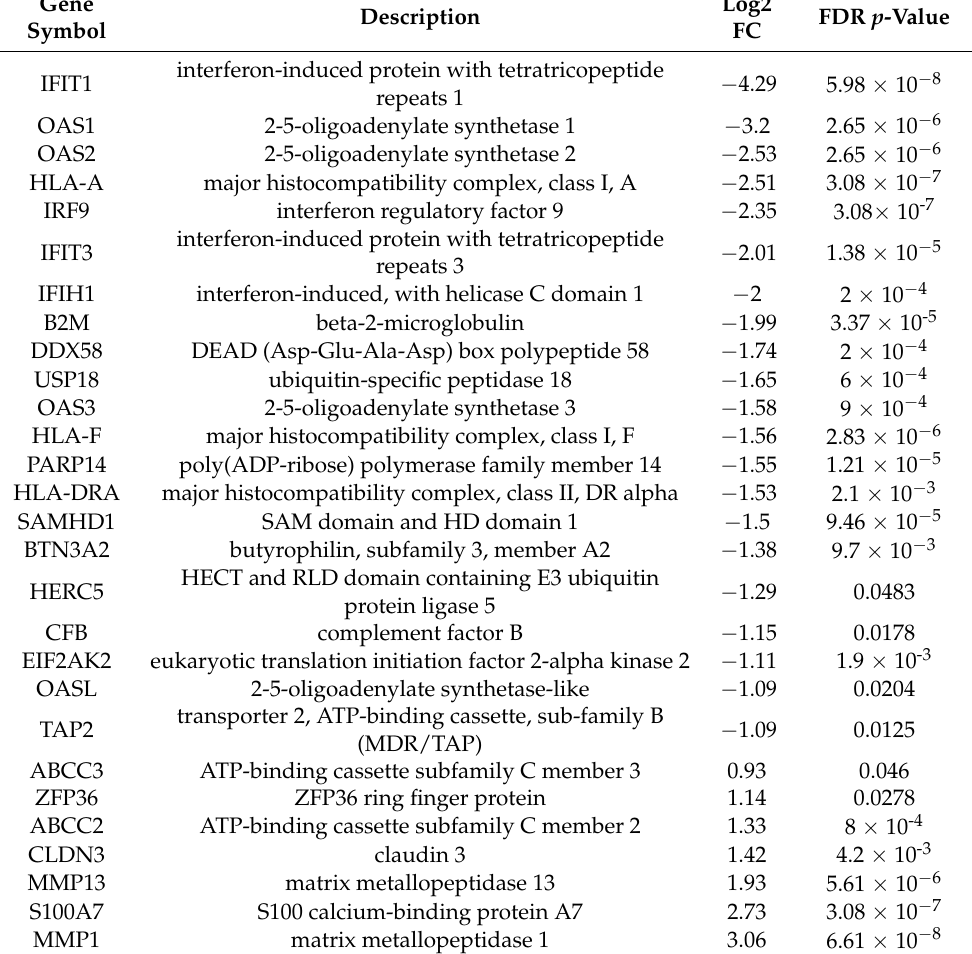
Table 4. List of common genes involved in the enriched